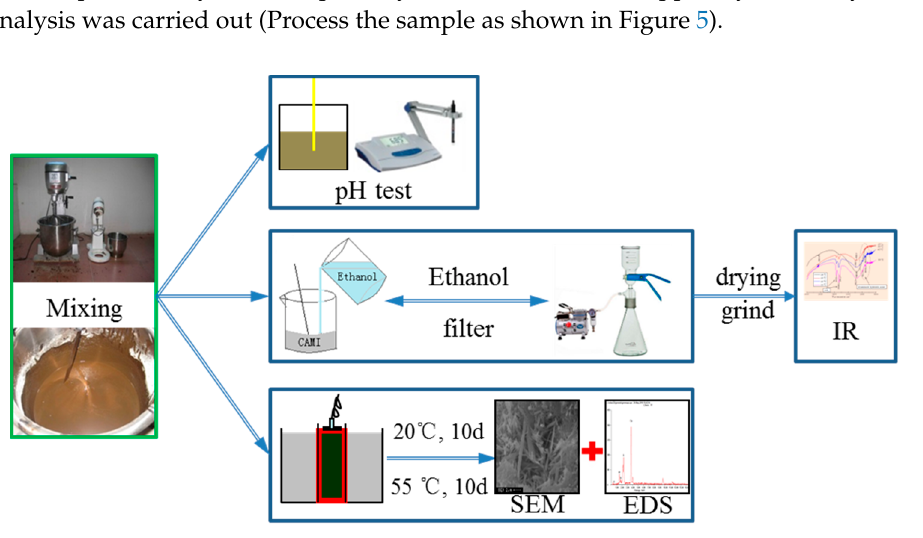
Table 4. Summary of test program.